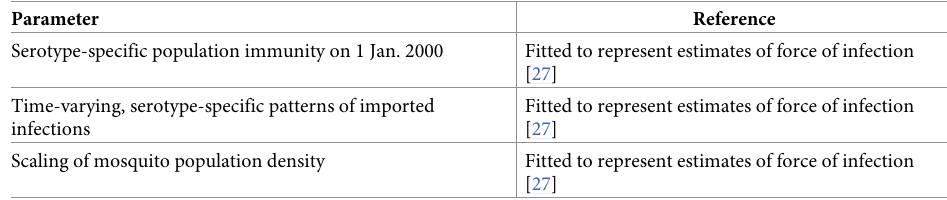
Table 3. Calibrated parameters.